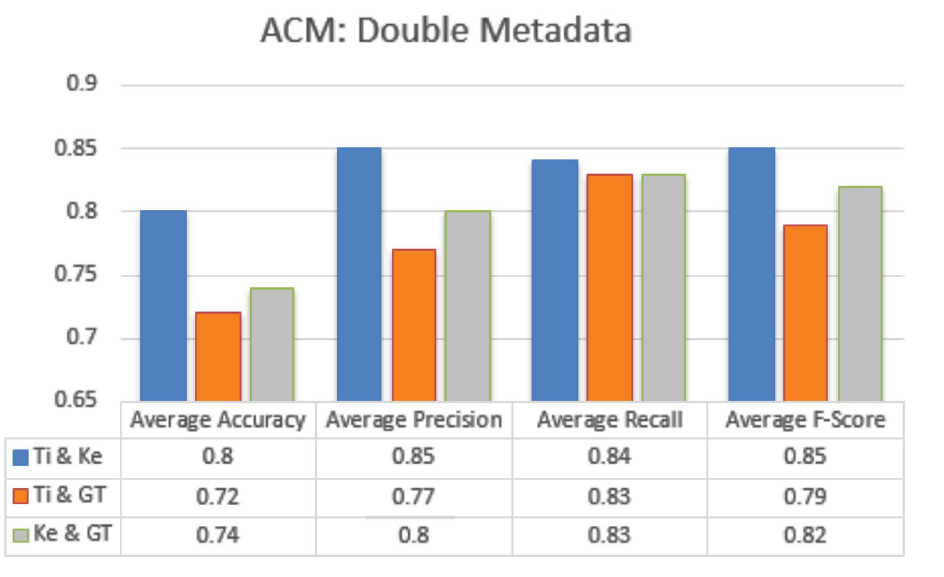
Figure 16. ACM (double meta